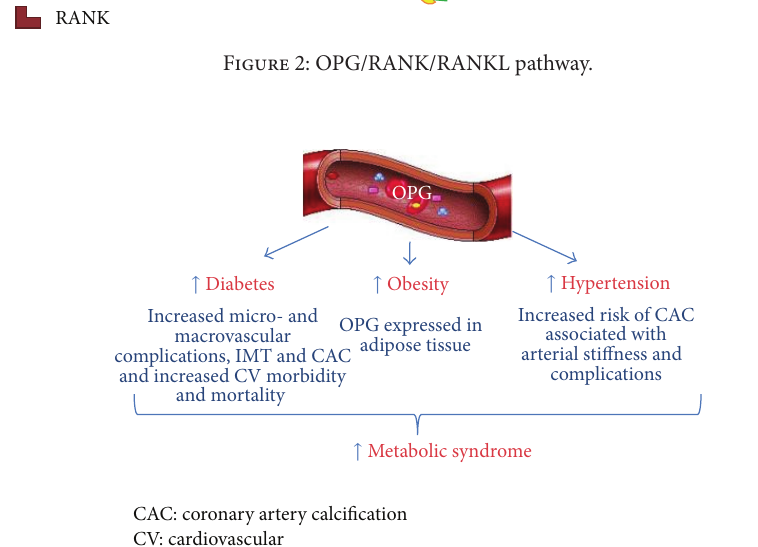
Figure 2: OPG/RANK/RANKL pathway.